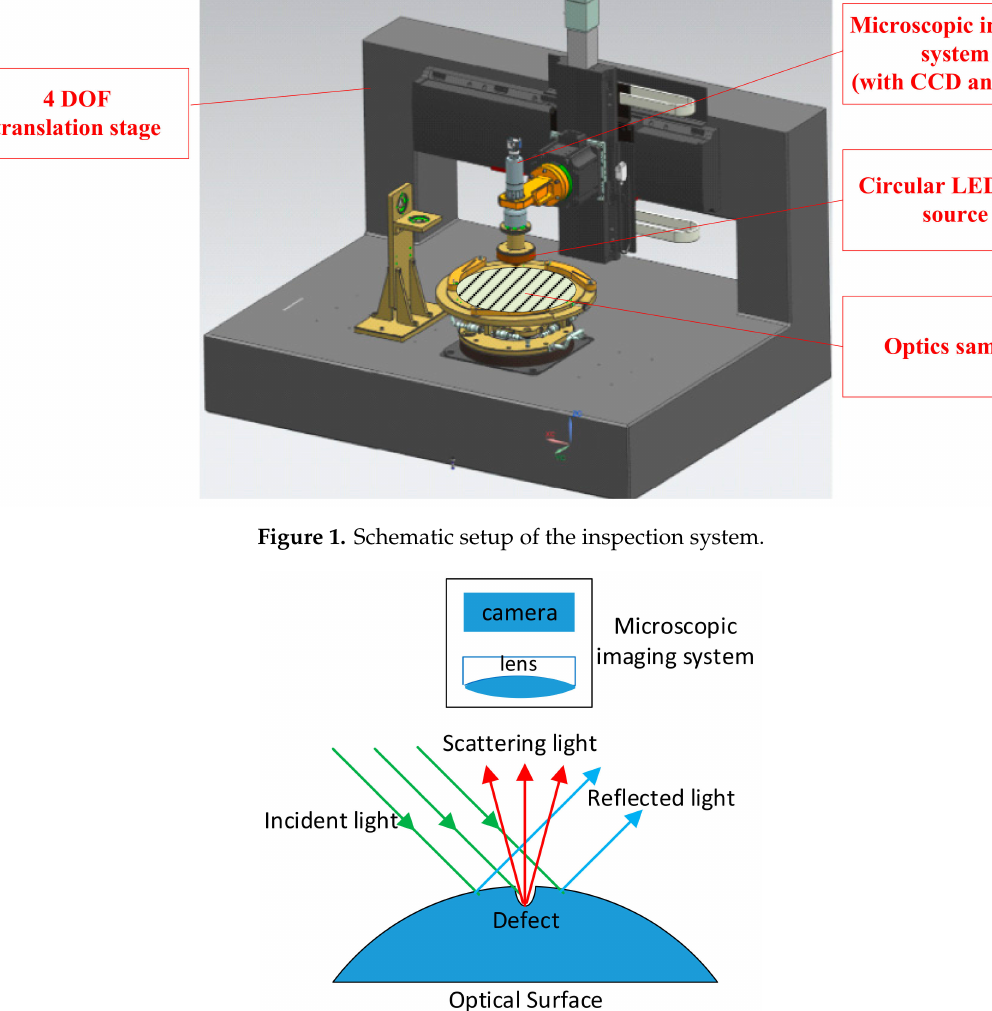
Figure 2. Principle of dark-field imaging